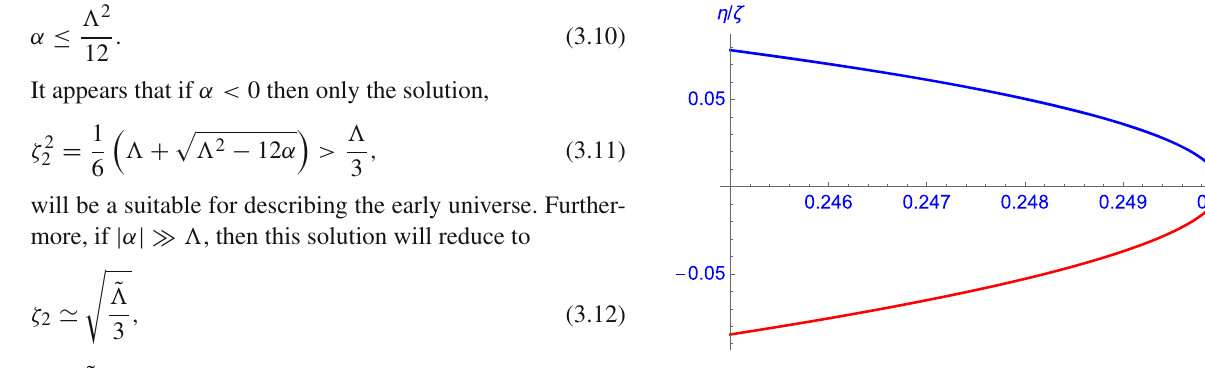
Fig. 1 Aratio η/ζ asfunctionsof κ with (cid:7) = 1.Herethelowerredand upper blue curves correspond to the ratios η + /ζ and η − /ζ ,